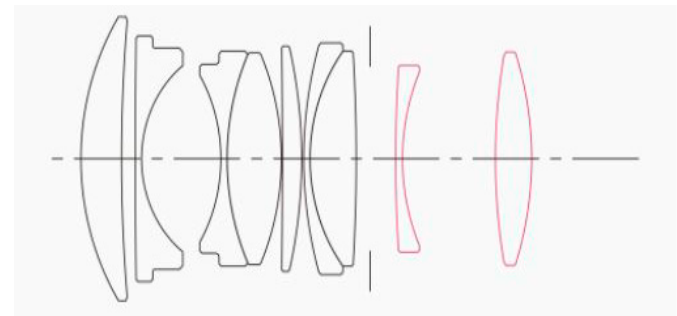
Figure 2. Sigma lens construction schematic.